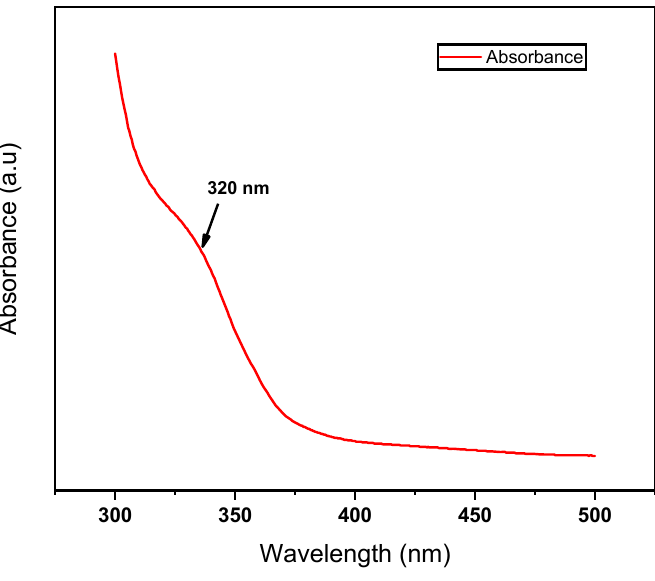
Figure 3. UV–Vis of GQD/300.